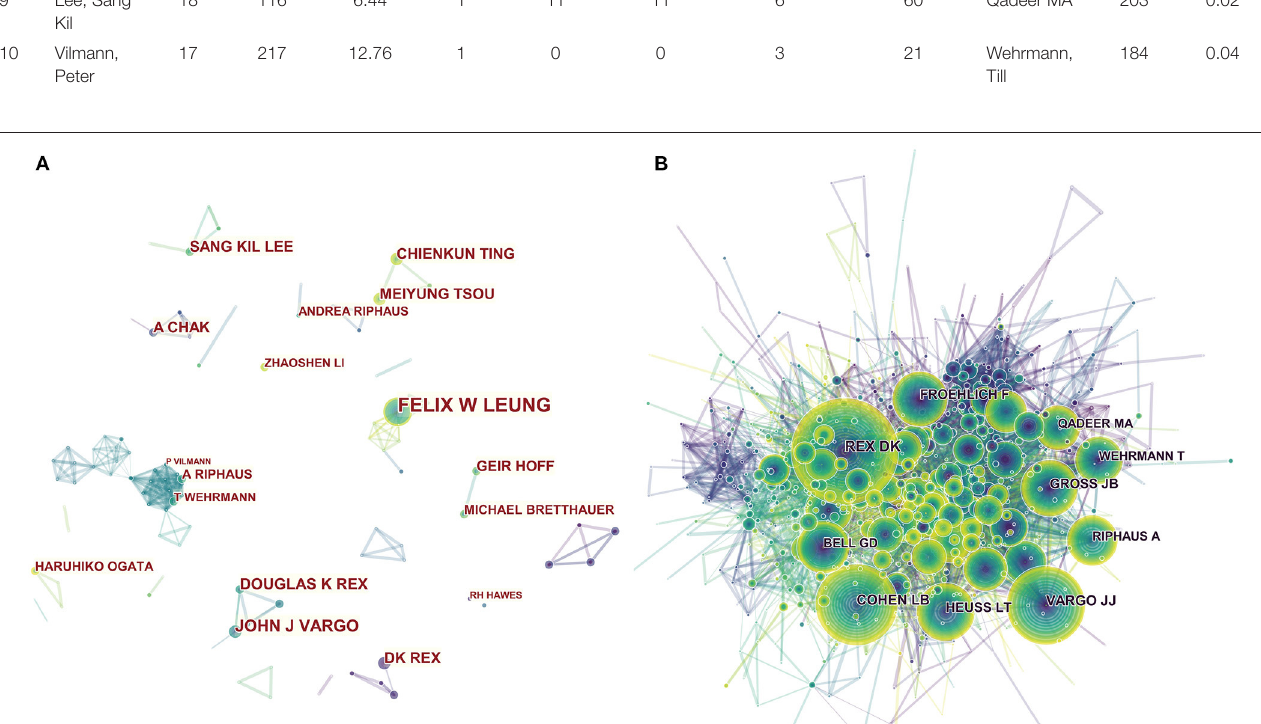
FIGURE 4 | The network map of productive authors (A) and co-cited authors (B) participated in Endoscopic Sedation research.